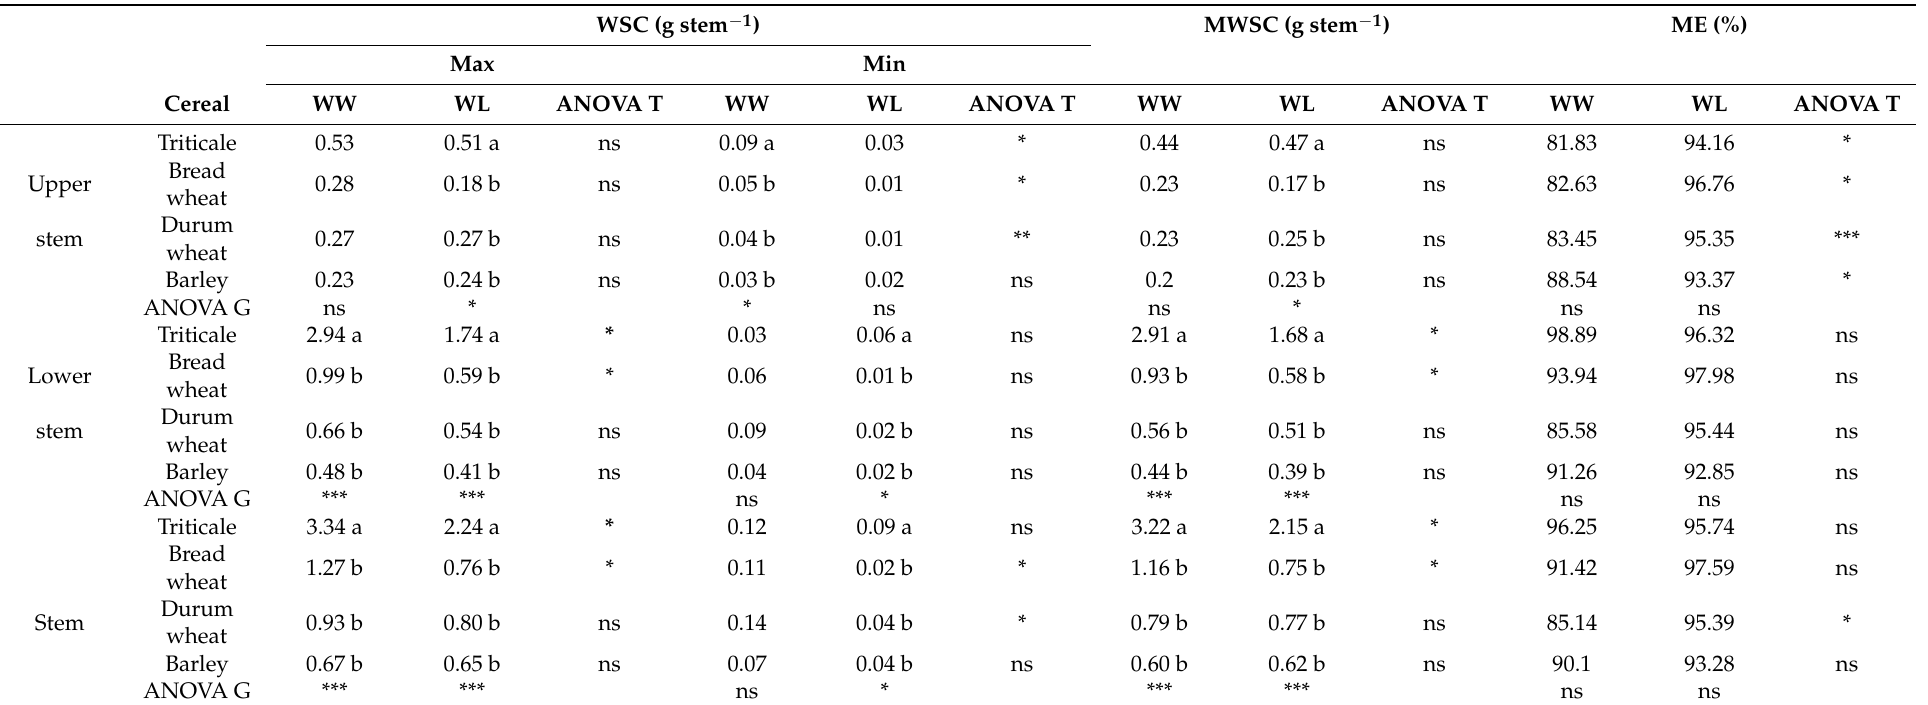
Table 1. The maximum and minimum water-soluble carbohydrates (WSC), mobilisation of WSC (MWSC) from the upper stem (peduncle and second internode), the lower stem (rest of the internodes) and the whole stem, and mobilisation efficiency (ME) in triticale, bread wheat, durum wheat and barley grown under well-watered (WW) and water-limited (WL) regimes. The ANOVAs for each treatment were performed to compare water regimes within each genotype (ANOVA T) and to compare genotypes for each water regime (ANOVA G). Means with a common letter are not significantly different among